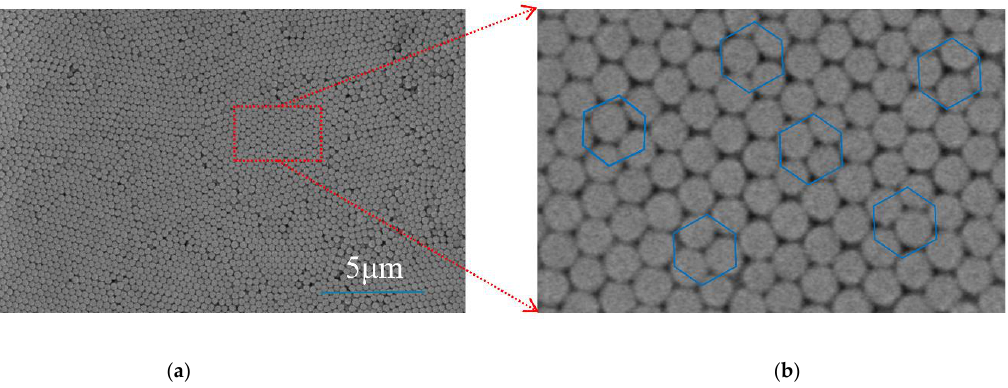
Figure 3. ( a ) SEM image of SiO 2 @PDA (271 nm) photonic crystal on silk ( b ) is a partial enlargement of the red box in ( a ).